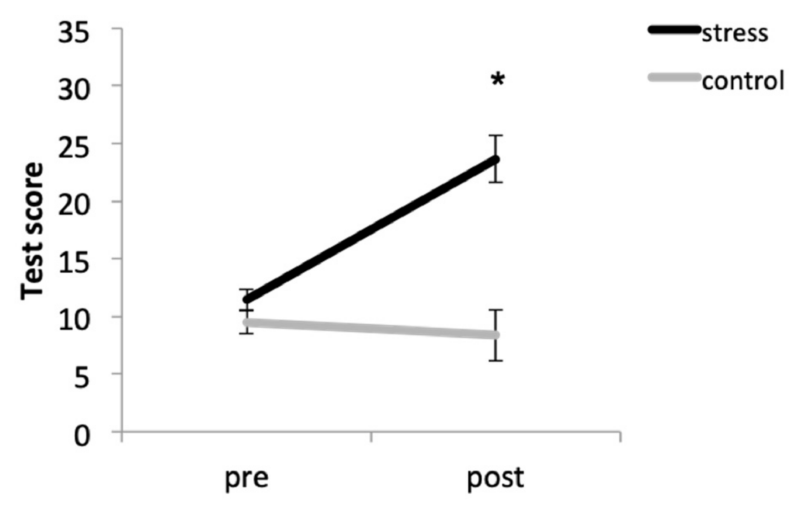
Figure 1. Anxiety scores before (pre) and after (post) the stress or control tasks (* p <